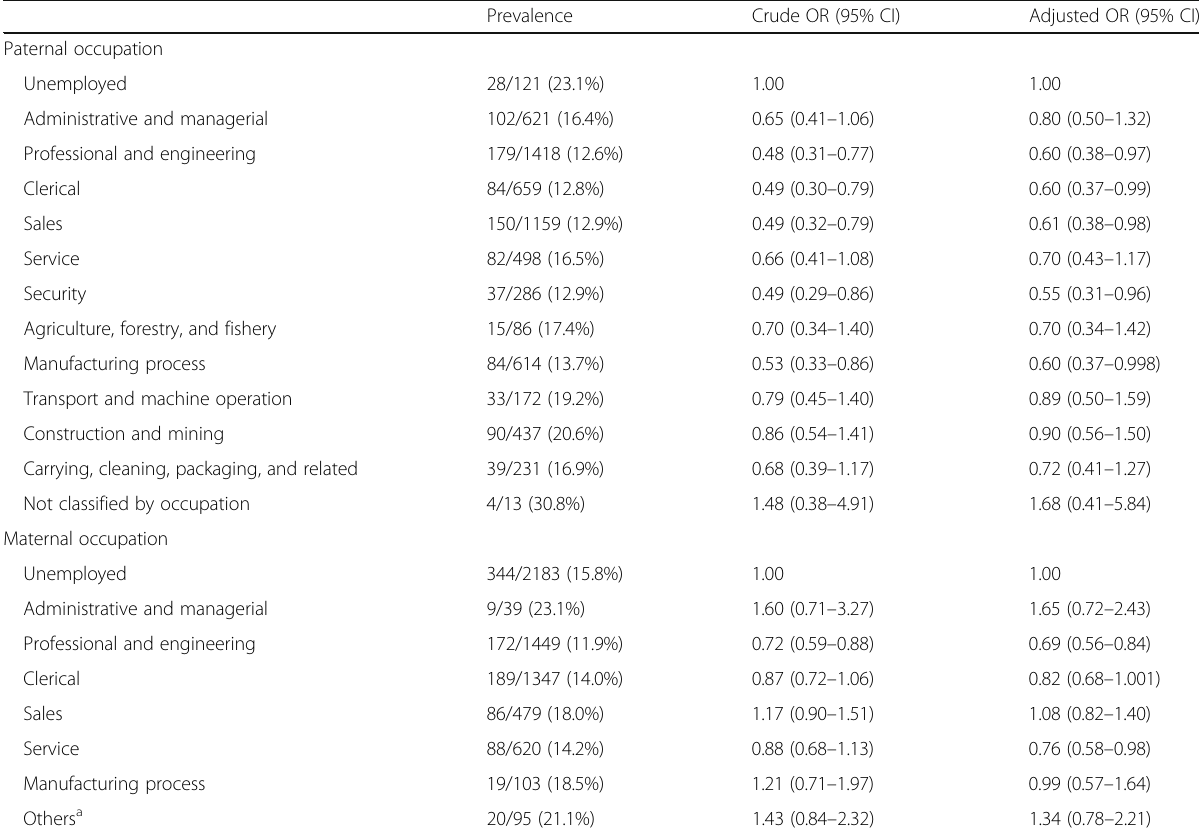
Table 2 ORs and 95% CIs for dental caries in relation to parental occupation in 6315 Japanese children aged 3